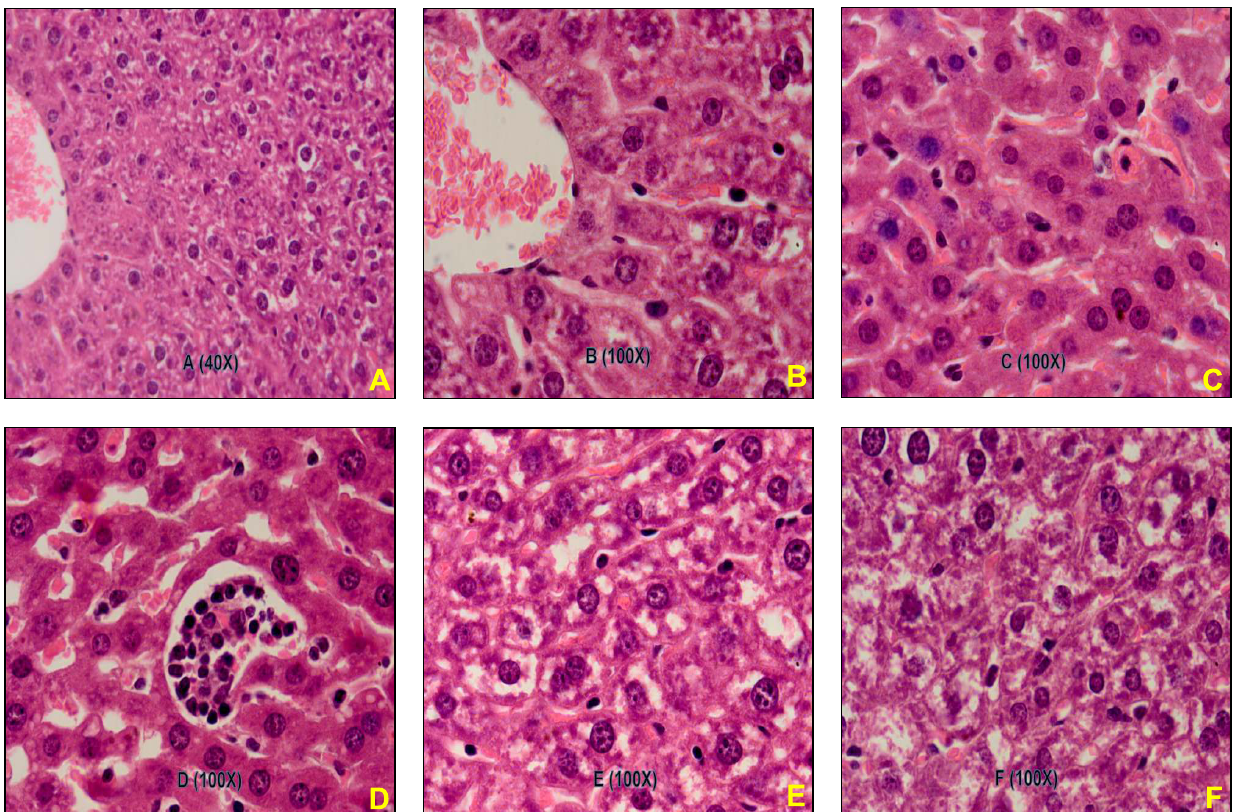
Figure-1. Histological analysis (at 40X and 100X magnification) of the liver tissues of male mice given oral treatment with deltamethrin for 15 days at a dose rate of 0.1 and 0.5 mg/kg body weight and for 30 days at a dose rate of 0.1 and 0.5 mg/kg body weight. (A) Control (40X), (B) Control (100X), (C) 0.1 mg/kg dose for 15 days, (D) 0.5 mg/kg dose for 15 days, (E) 0.1 mg/kg dose for 30 days, and (F) 0.5 mg/kg dose for 30